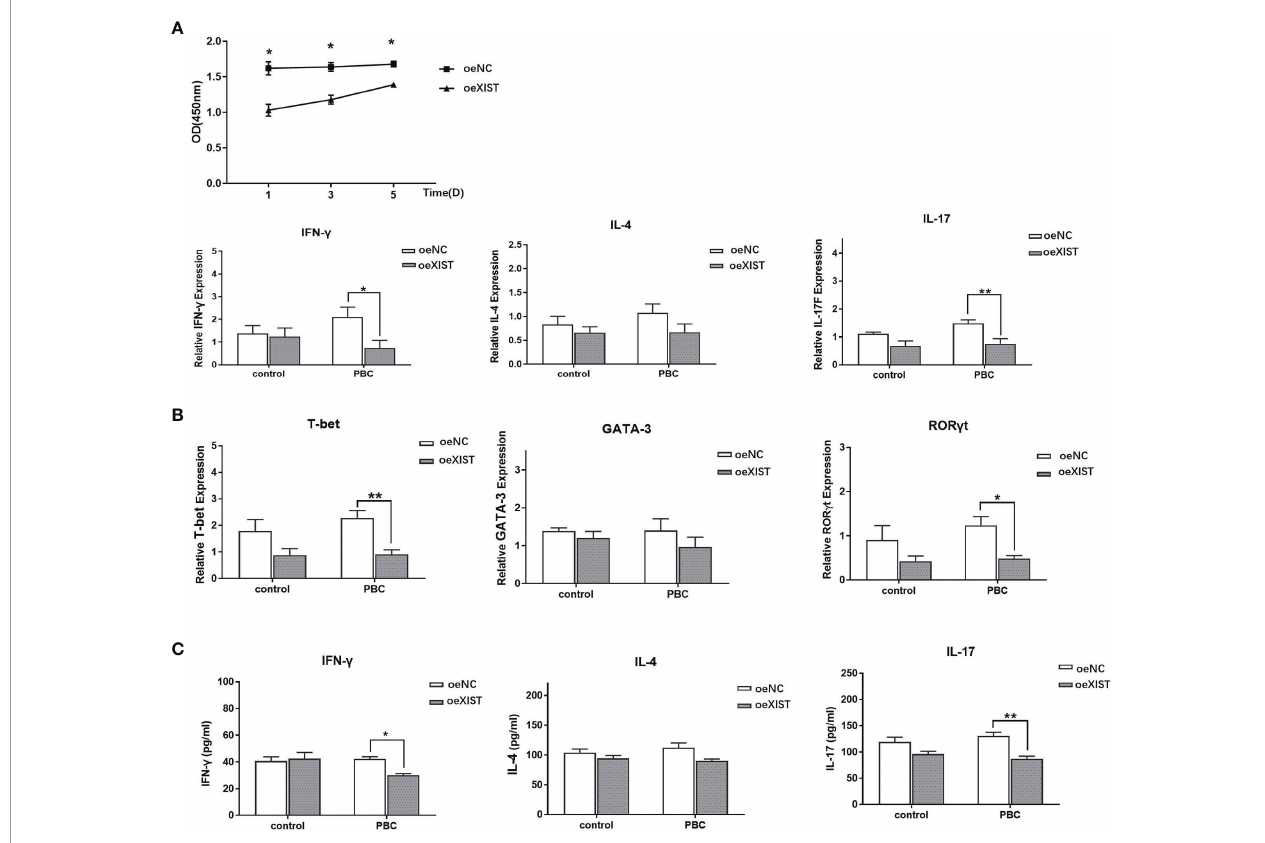
FIGURE 4 | LncRNA XIST affects the proliferation and difference of naive CD4+ T cells. (A) The proliferation of naive CD4+ T cells in PBC patients (n=20) was analyzed by CCK8. Compared with naive CD4+ T cells in the oeNC group, the proliferation ability of naive CD4+ T cells in the oeXIST group was decreased at different time periods. The data are presented as mean±SEM of three independent experiments. *p < 0.05. (B) After co-culture, qRT-PCR was used to detect the expression of IFN- g , IL-4, IL-17, T-bet, GATA-3 and ROR g t in PBC patients (n=20). The data are presented as mean±SEM of three independent experiments (*p < 0.05; **p < 0.01). (C) After co-culture, the expression level of IFN- g , IL-4 and IL-17 at the protein level in PBC patients (n=20) were detected by ELISA. The data are presented as mean±SEM of three independent experiments (*p < 0.05; **p <